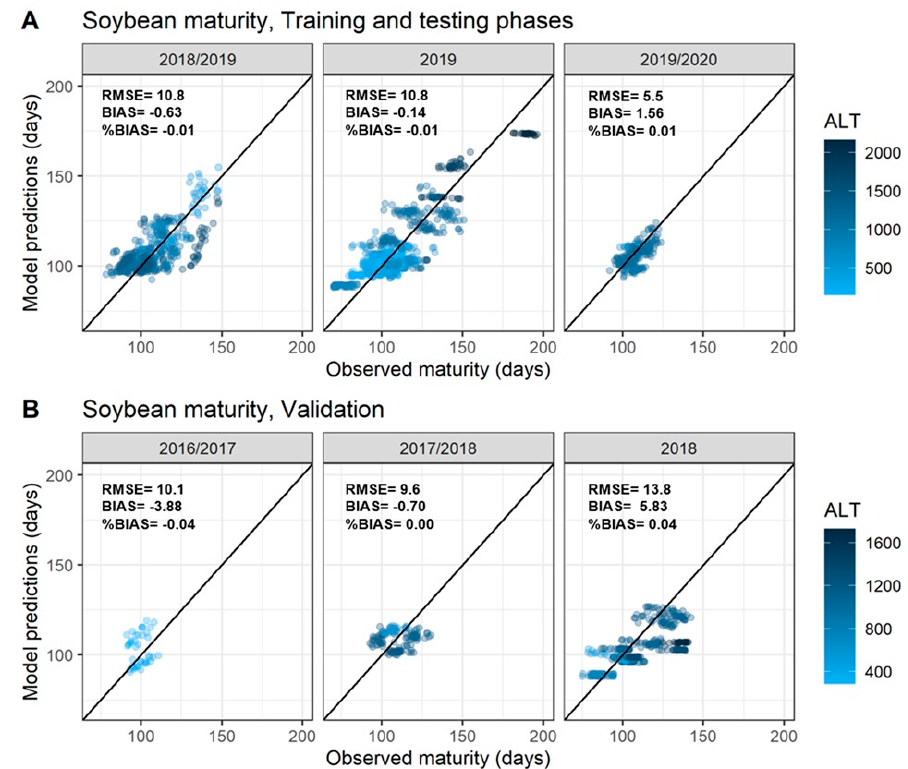
Figure 6. Implementation of a generalized additive model (GAM) to predict soybean time to ma-